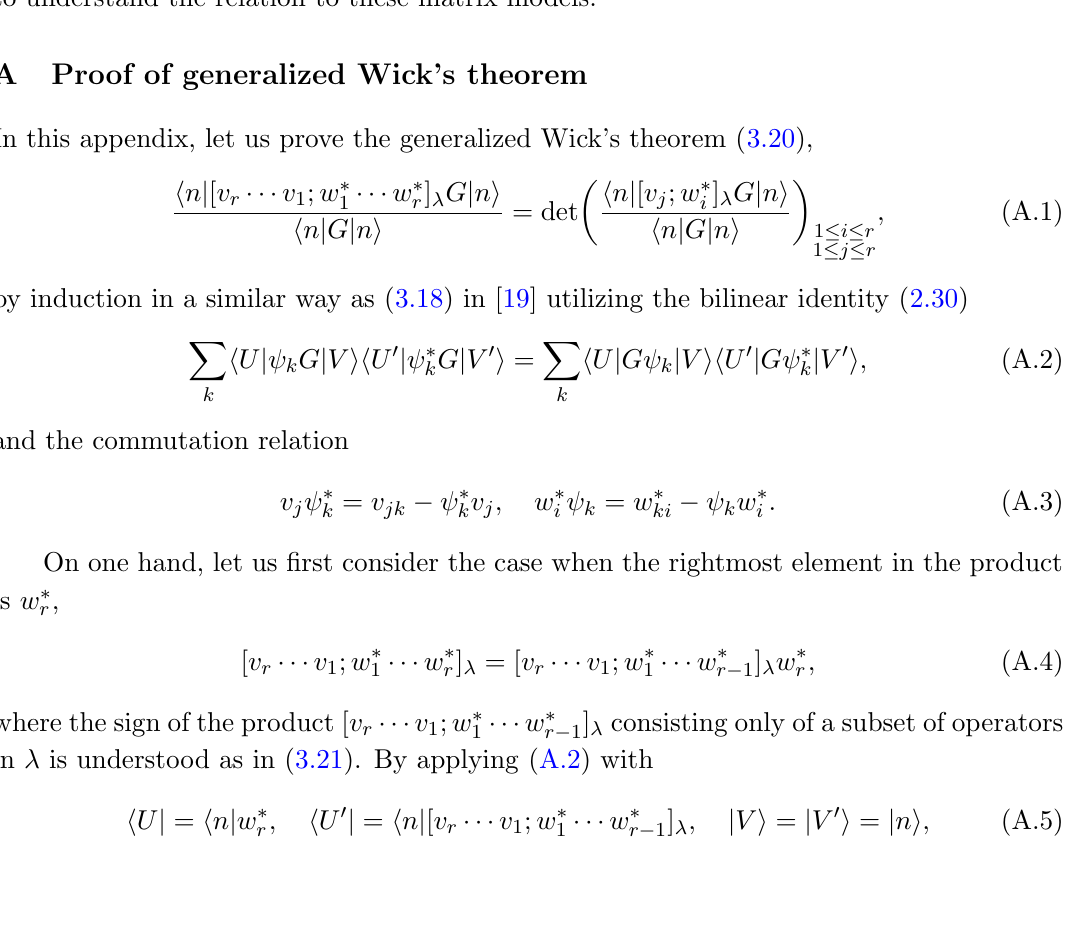
(cid:1) (cid:1) (cid:1) w (cid:3) ] (cid:21) . (Left) In the removal of w (cid:3) r 1 (cid:1) (cid:1) (cid:1) w (cid:3) ] (cid:21) w (cid:3) , while the removal of v j =3 causes an extra sign, ( (cid:0) 1) (cid:21) 0 j =3 = ( (cid:0) 1) 3 , as can be 1 4 5 (cid:1) (cid:1) (cid:1) w (cid:3) ] (cid:21) = ( (cid:0) 1) 12 v 5 w (cid:3) 1 5